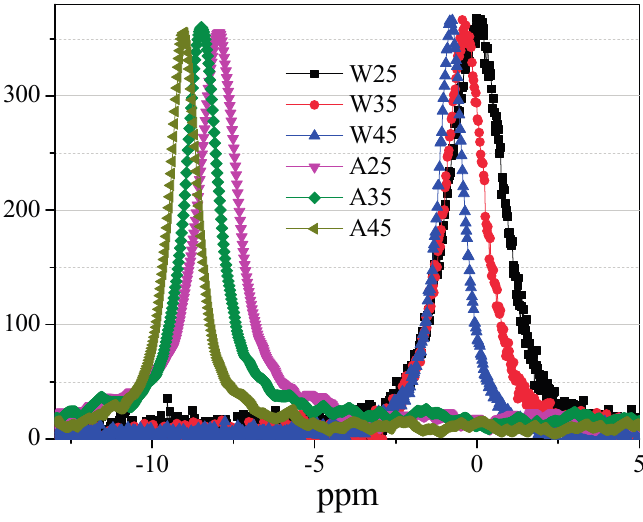
Figure 10. 17 O-NMR spectroscopy of water and acetone. W25, W35, W45, A25, A35 and